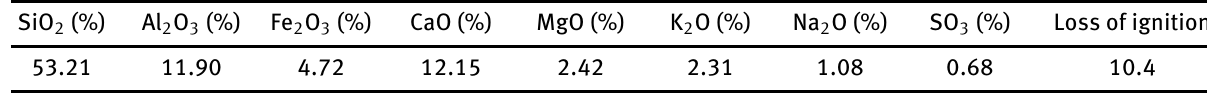
Table 3: Main chemical composition of fine aggregates of construction waste.